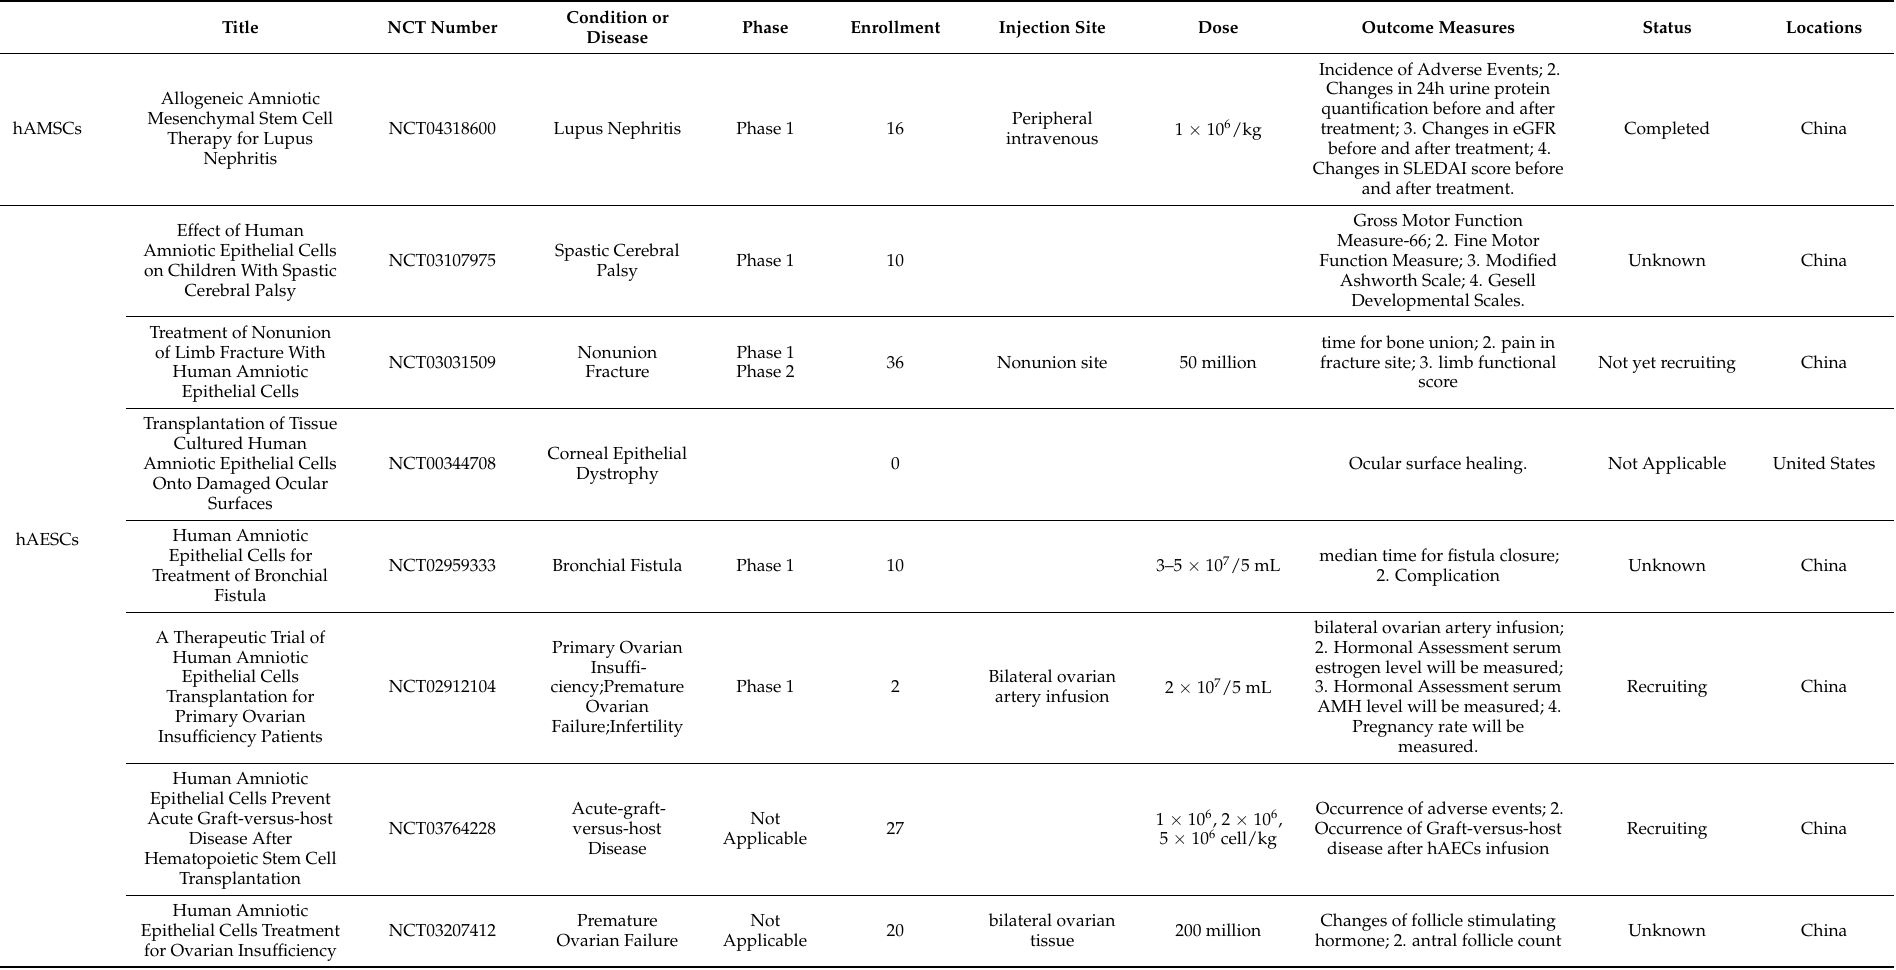
Table 2. Clinical trials using hAMSCs and hAESCs as a biological